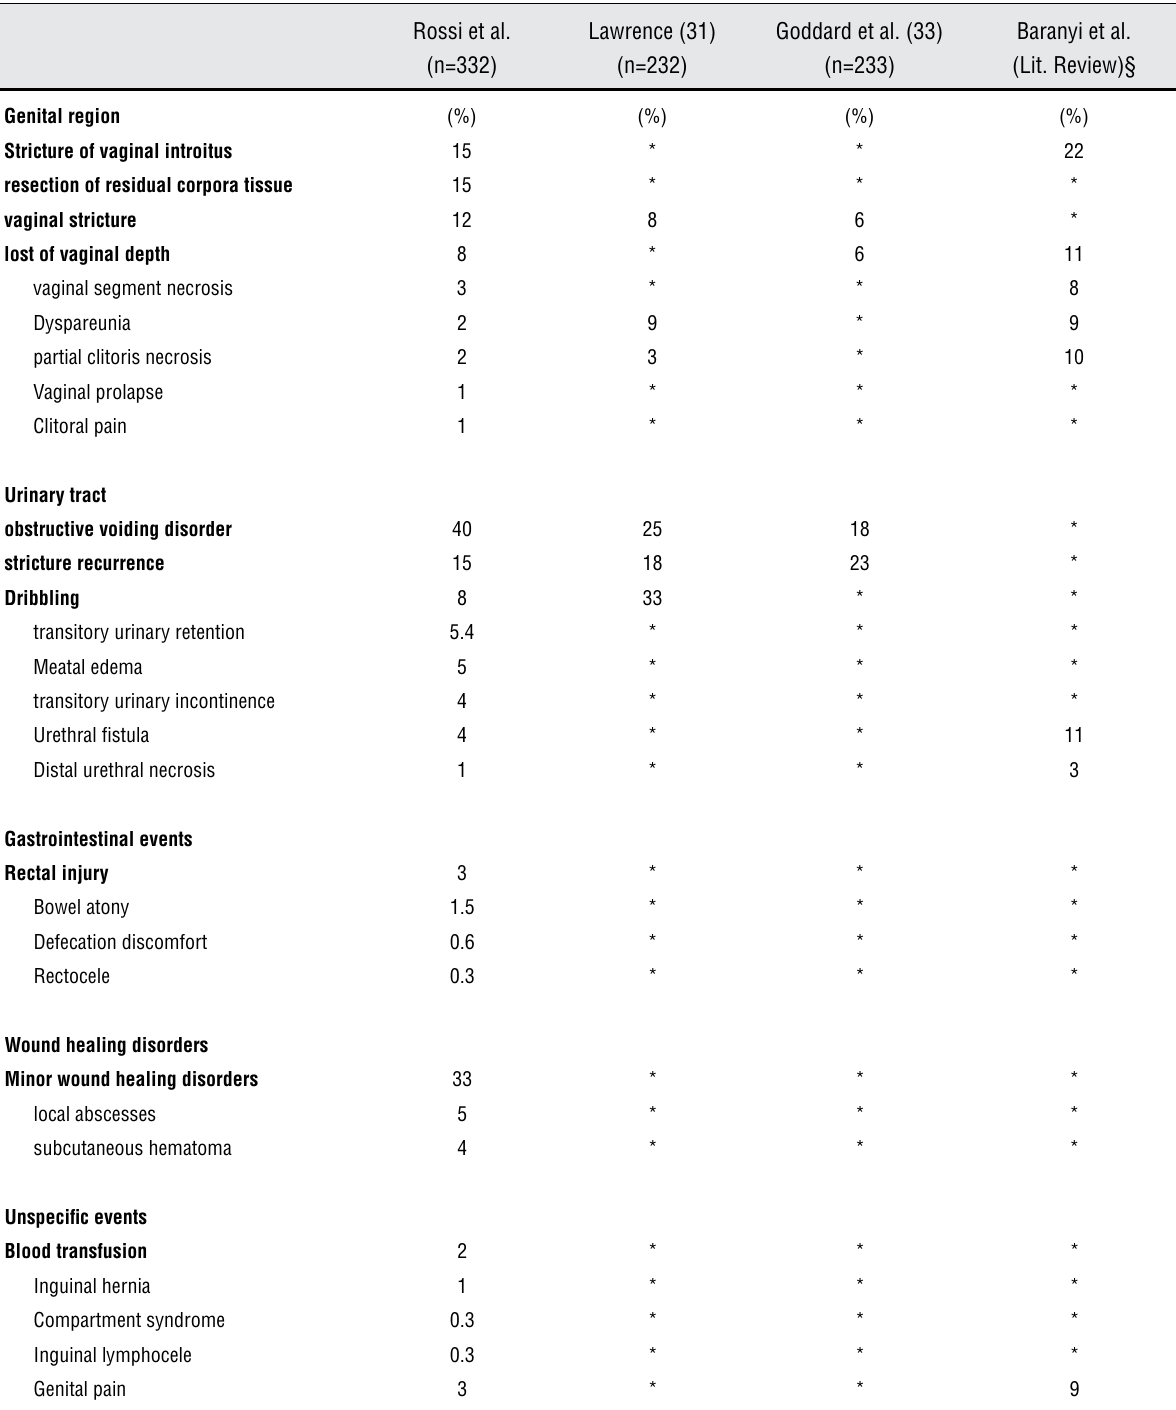
Table 1 - Complications after gender reassignment surgery †